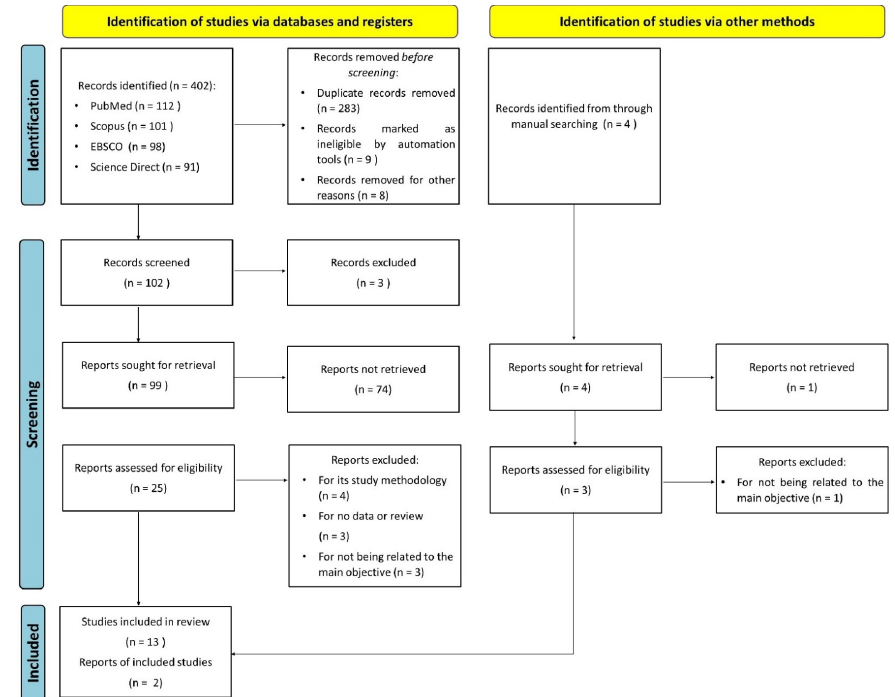
Figure 1. PRISMA flowchart of the inclusion